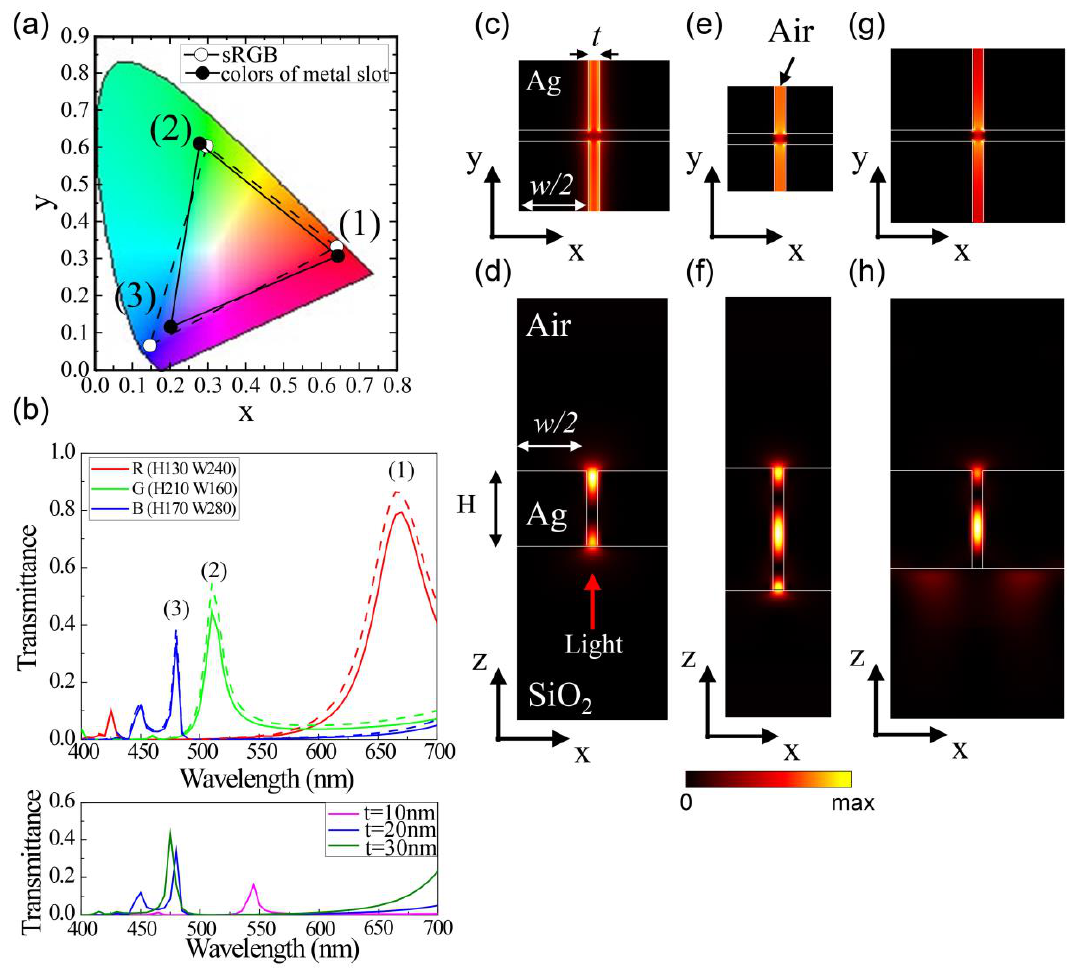
Figure 4. ( a ) Transmitted colors of silver blocks (solid lines) and sRGB area (dashed lines) in CIE color coordinate. (1), (2), and (3) indicate the three representative colors shown in Figure 3 and the structural height and width ( H , W ) of silver blocks for each RGB color are (130 nm, 240 nm), (210 nm, 160 nm), and (170 nm, 280 nm), respectively; ( b ) (Top) Transmittance spectra of three representative structures. When light is incident from SiO 2 substrate (air) side, transmittance spectra are indicated as solid (dashed) lines. (Bottom) Transmittance spectra of blue structure for different slot thickness of 10, 20, and 30 nm; ( c – h ) Electric field intensity profiles of the transmitted light when linearly polarized light E x with a wavelength at the transmission peak is normally incident from SiO 2 substrate for three-color structures; (c), (e), and (g) show top-views of transmitted light measured from air side; (d), (f), and (h) show cross-sectional views; (c,d), (e,f), and (g,h) correspond to (1), (2), and (3).